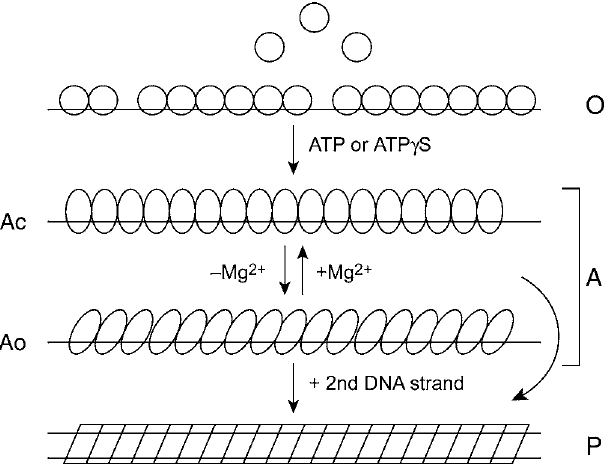
Figure 2. Four Structural States of RecA Protein The O state is present in the absence of ATP or ATP analogs, whether the protein is free in solution or bound to DNA. The A state is found on ssDNA in the presence of ATP. Two versions of the A state, Ac and Ao, are found at different Mg 2 þ concentrations. Addition of a second DNA strand to the RecA filament converts it to the P state. DOI: 10.1371/journal.pbio.0030052.g002